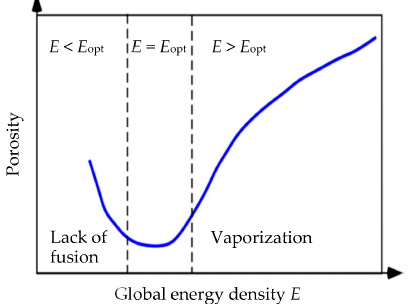
Figure 1. Effect of global energy density E on porosity in an SLM-processed Ti-6Al-4V alloy (schematic after [4,23]).